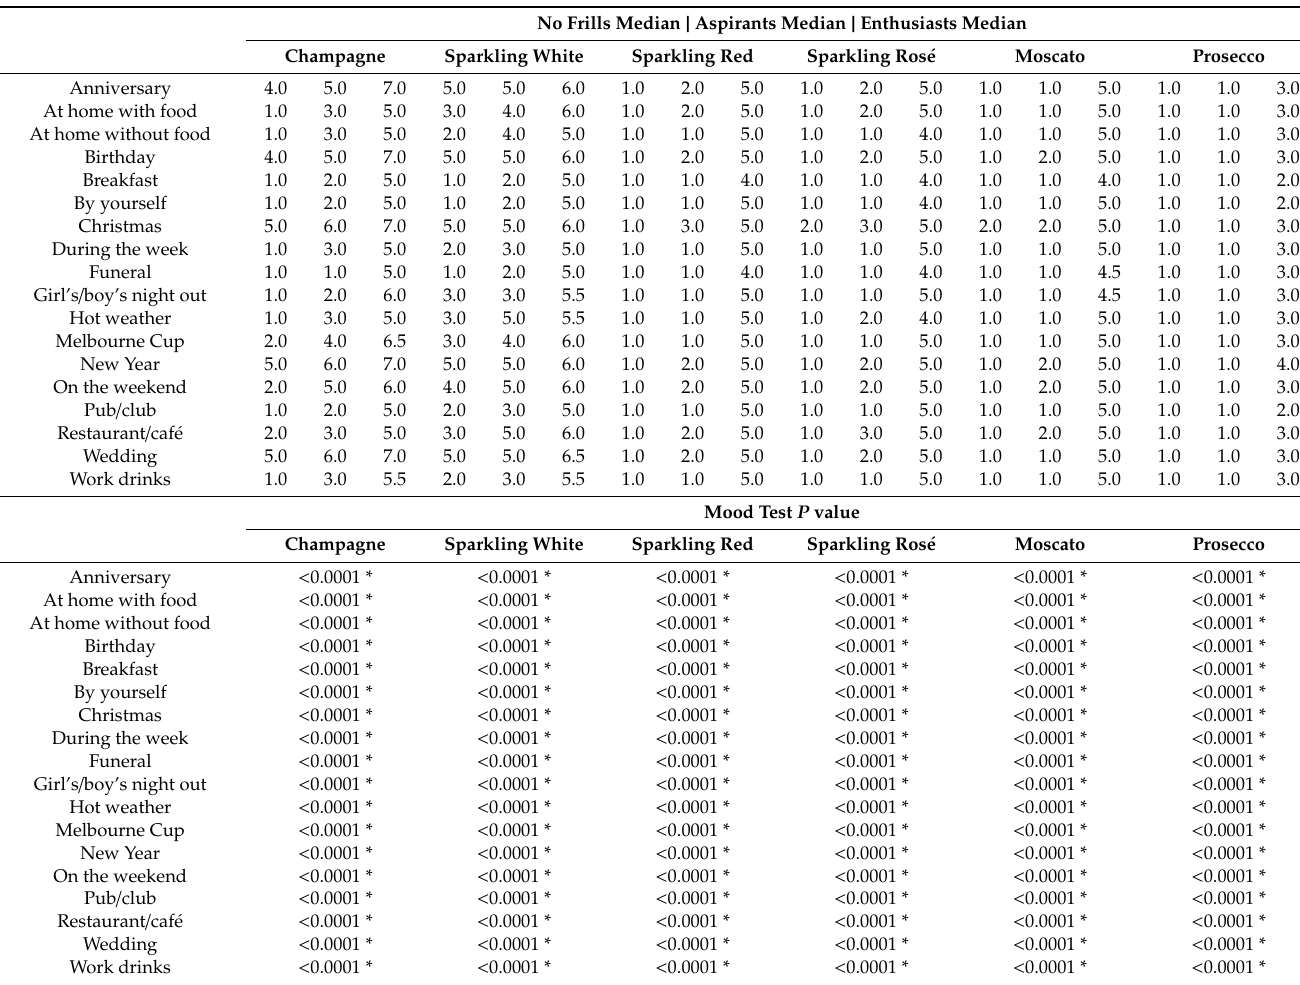
Table 7. Median consumption scores at occasions and comparisons of Fine Wine Instrument consumer segments for di ff erent sparkling wine